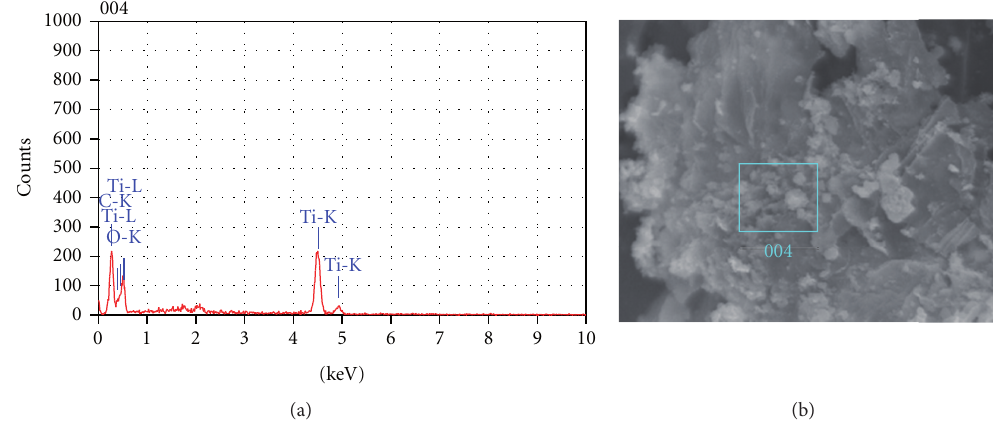
F 5: (a) EDX area analysis and (b) SEM micrograph for the TiO